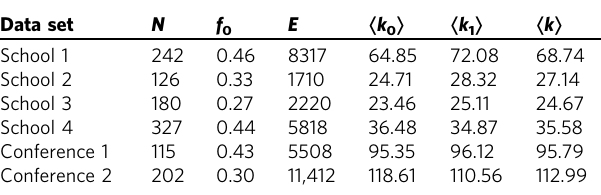
Table 1 The social networks from six different studies. Data